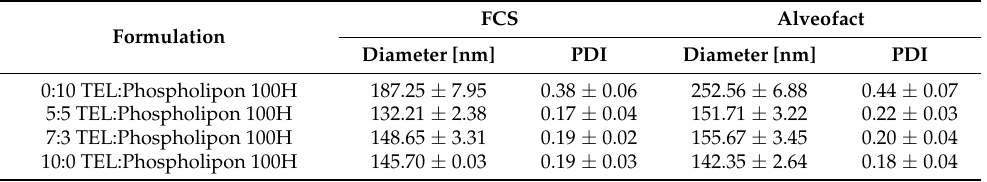
Table 5. The mean hydrodynamic diameter and polydispersity index (PDI) of liposomes composed of tetraether lipids (TEL) and Phospholipon 100H (Ph) in different molar ratios (0:10, 5:5, 7:3, 10:0; TEL:Ph) after 4 h incubation with Alveofact and fetal calf serum (FCS), respectively.